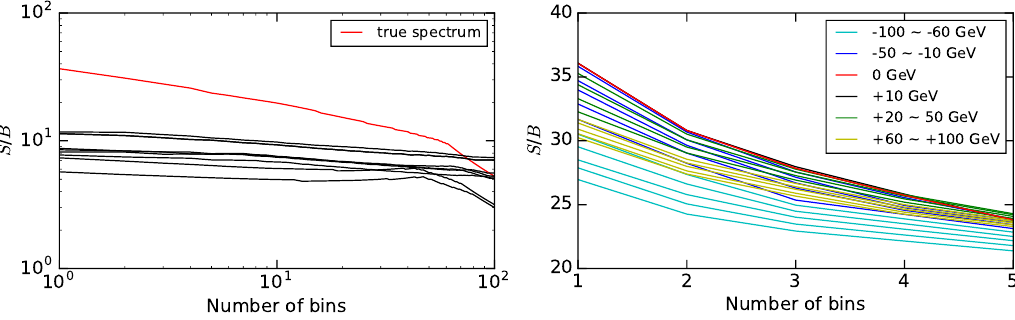
Figure 9 . Performance curves for (cid:1) 4 calculated by using a range of hypothesis spectra and the S/B metric. Left: each one of the plotted curves corresponds to deforming the spectrum by changing each of the four masses up or down by 10 GeV. For comparison, the red curve highlights the (cid:6) true spectrum. Right: each one of the curves corresponds to deforming the spectrum along the (cid:13)at direction described in the main text over a wide range. The color scheme corresponds to the change in the mass of the